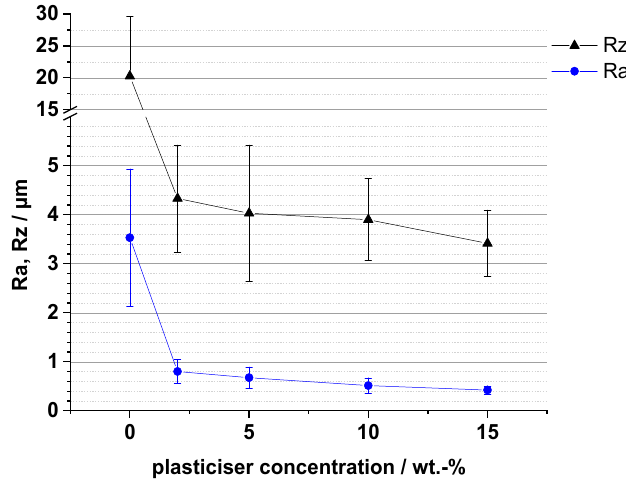
Figure 16. Roughnesses of PHBV layers blended with triethyl citrate (TEC), constant MFR (melt flow rate during extrusion).